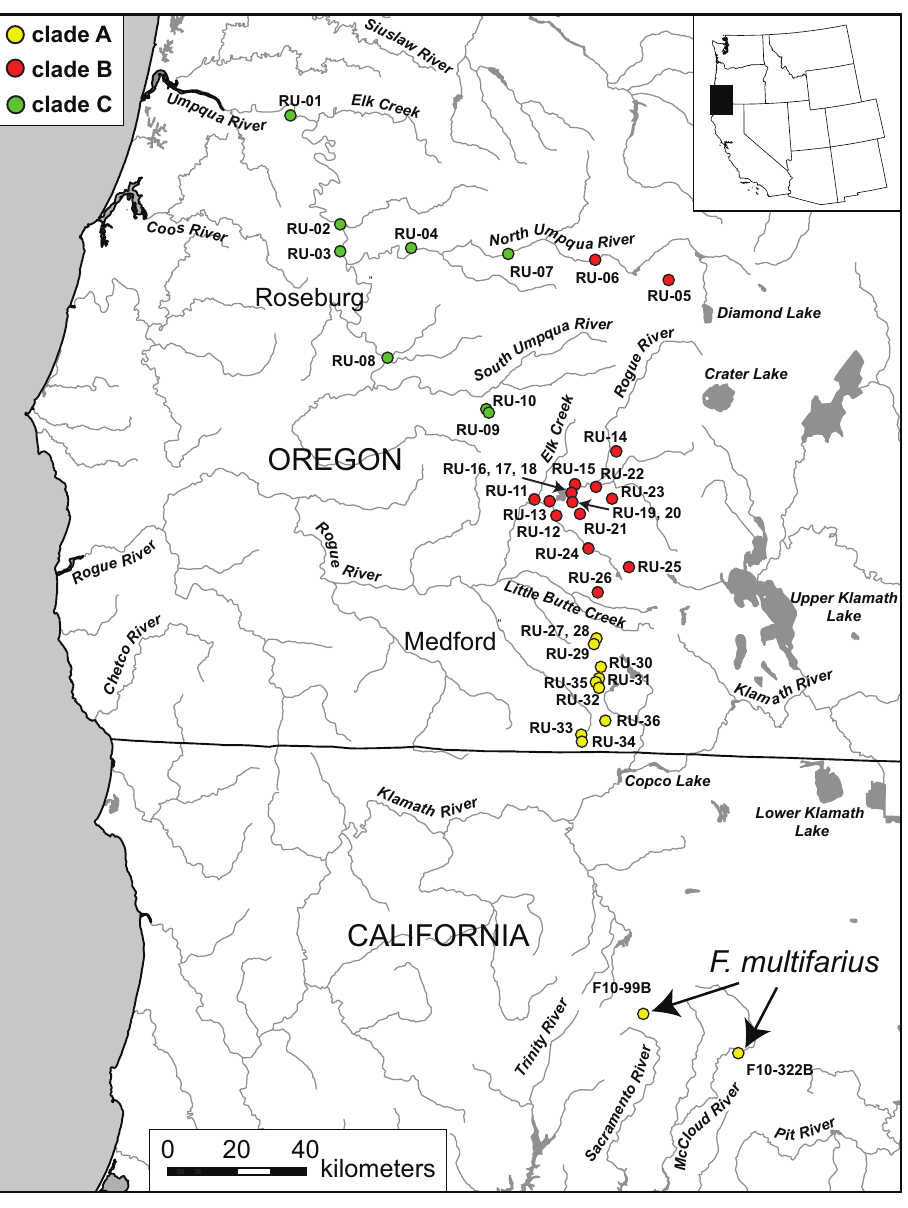
Figure 2. Map of southwest Oregon and northwest California showing the distribution of mtDNA clades A–C with color codes matching those in Fig. 1. Specimen codes are from Suppl. material 1.